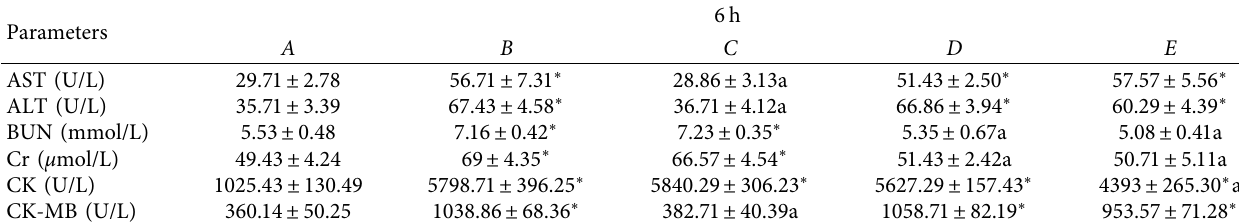
Table 2: Outcomes of blood biochemical analysis in rabbits 6 hours after the injection with Naja atra venom. Parameters